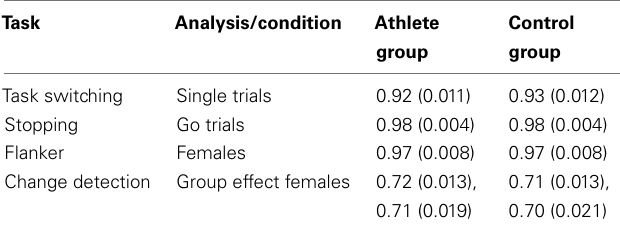
Table 2 | Mean accuracy values of the speed-accuracy tradeoff analyses.